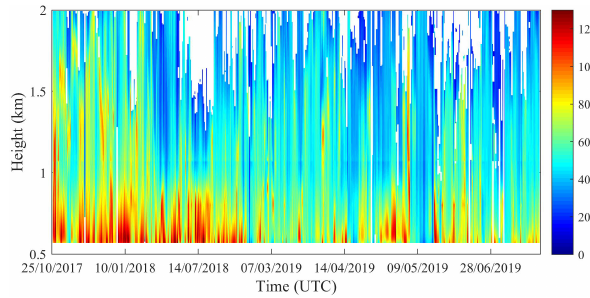
Figure 5. The averaged LR of effective observation hours. The white areas indicate invalid